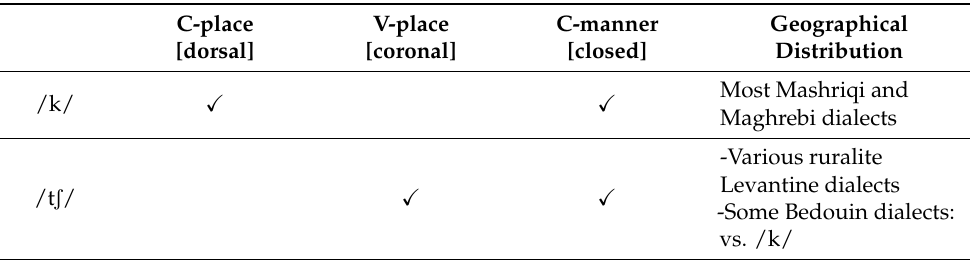
Table 3. Representational typology of * k phoneme reflexes. C-place V-place C-manner Geographical [dorsal] [coronal] [closed] Distribution Most Mashriqi and /k/ (cid:88) (cid:88) Maghrebi dialects -Various ruralite Levantine dialects /t S / (cid:88) (cid:88) -Some Bedouin dialects: vs.